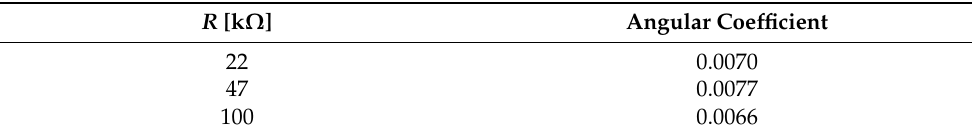
Table 2. Analysis of resistance dimensioning: angular coefficient of regression line of commercial sensor.